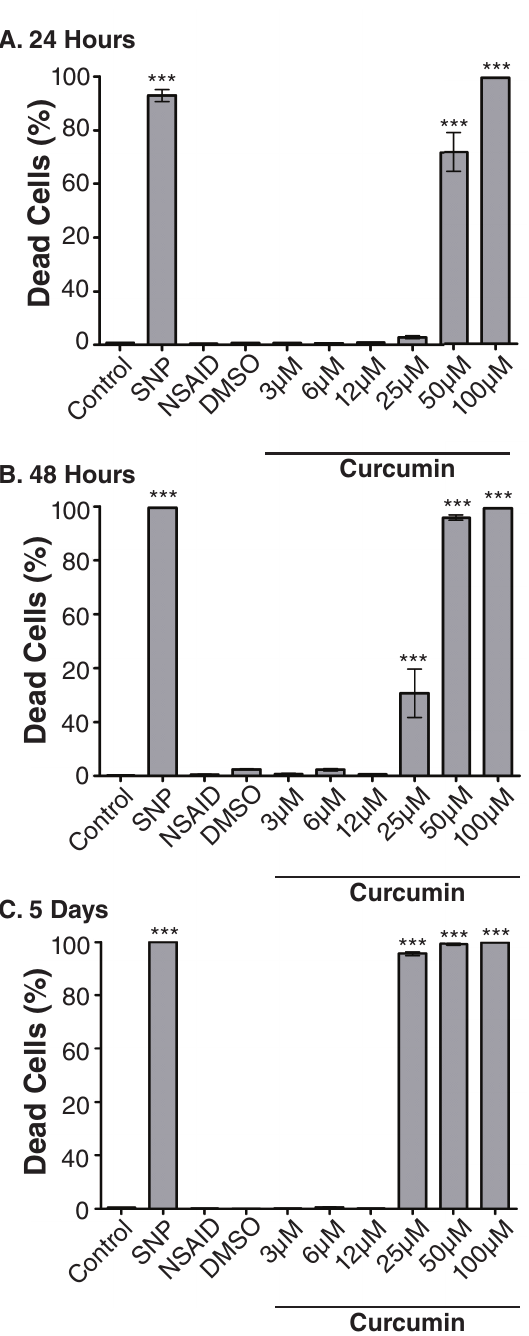
Figure 1. Curcumin significantly increases chondrocyte death after 24 hours ( A ) at 50μM and 100μM compared to control indicated by *** ( p <0.001). After 48 hours ( B ) and five days ( C ), curcumin (25μM) significantly increases chondrocyte death compared to controls. The nitric oxide donor, sodium nitroprusside (SNP) (50mM) also significantly increases chondrocyte death at 24 hours, 48 hours, and five days ( p <0.001) compared to control. DMSO at concentrations found in the 100μM curcumin treatment has no effect on chondrocyte death. Results are expressed as the mean number of dead cells per field of view per treatment ± SEM. Data presented are from 5 different animals with 2 technical replicates per